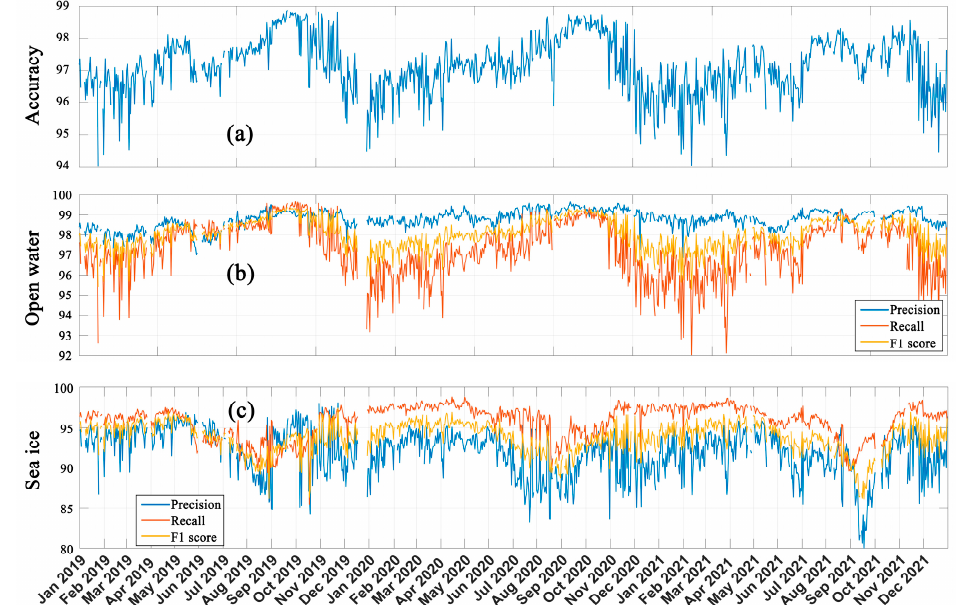
Figure 5. Time series of model performance in Arctic for the period from 2019 to 2021: ( a ) overall accuracy; and precision, recall and F1 scores for ( b ) open water and ( c ) sea ice.